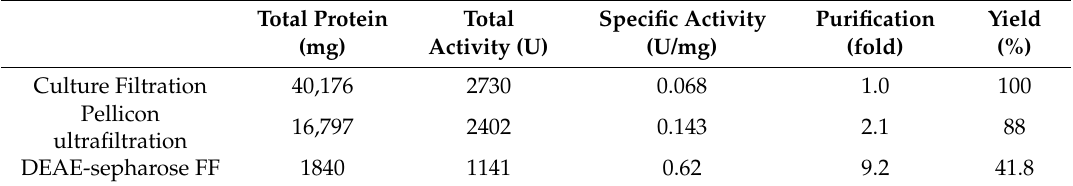
Table 1. Purification steps of β -glucosidase from a Y. lipolytica transformant (pYLSC1- bgl ).